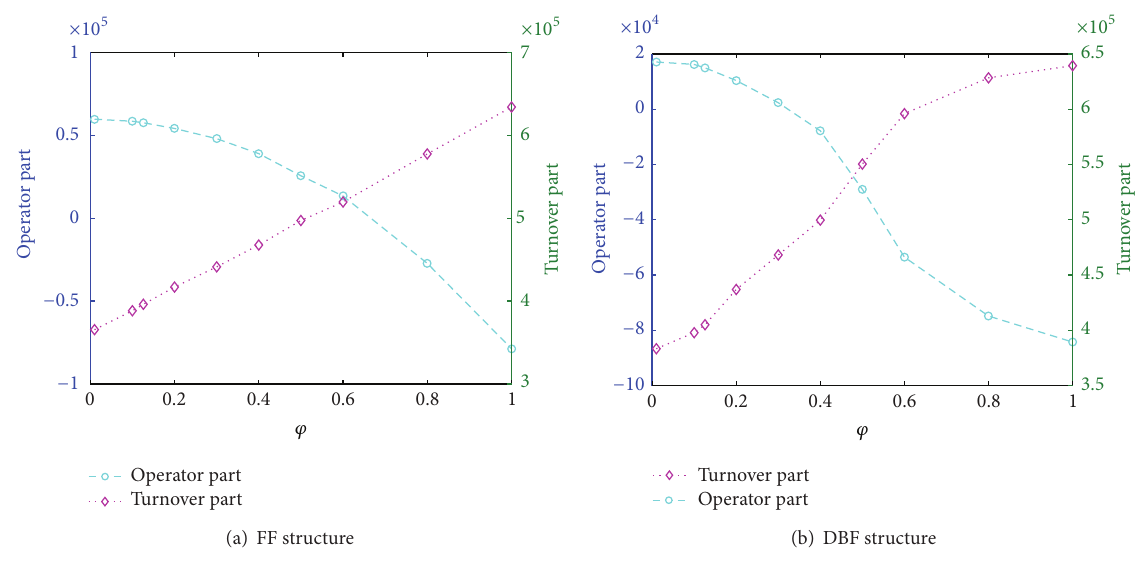
Figure 1: Relationship between objective function value and 𝜑 in M3. Table 2: Optimization results of different